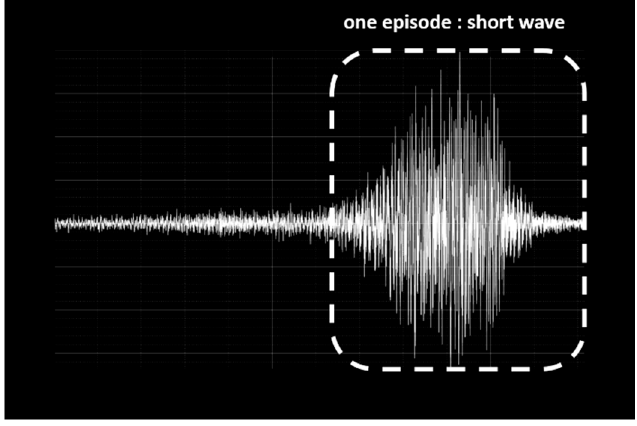
Figure 3. A short wave (SW) is defined as one episode.